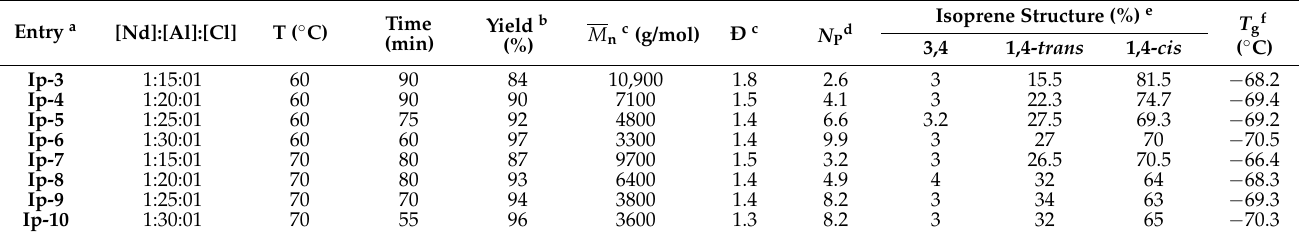
Table 2. Isoprene polymerization initiated by NdV 3 /Al( i -Bu) 2 H/Me 2 SiCl 2 in cyclohexane at different reaction conditions.